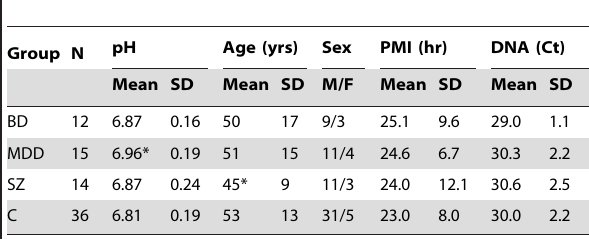
Table 7. Demographics of subjects from which DLPFC mtDNA was